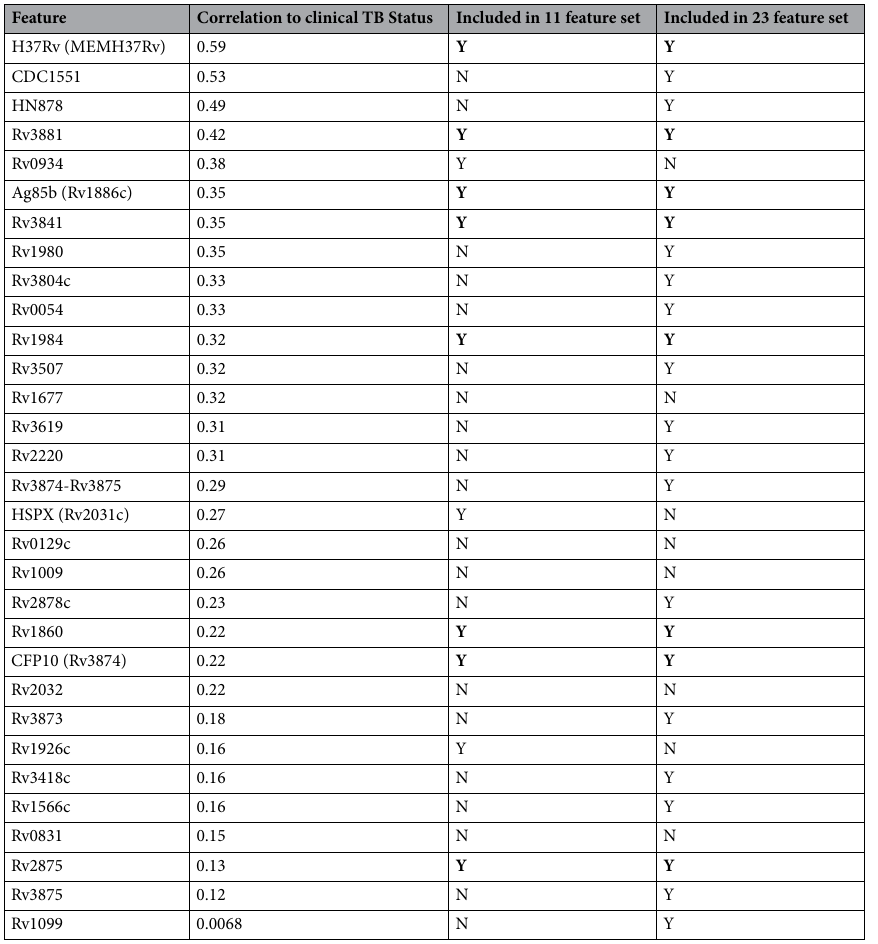
Table 3. Selected antigens for 11 and 23 feature sets for MILO models ranked by pearson correlation coefficient to clinical TB status. The bold represents the features that were present in both the 11 feature set and the 23 feature set data.